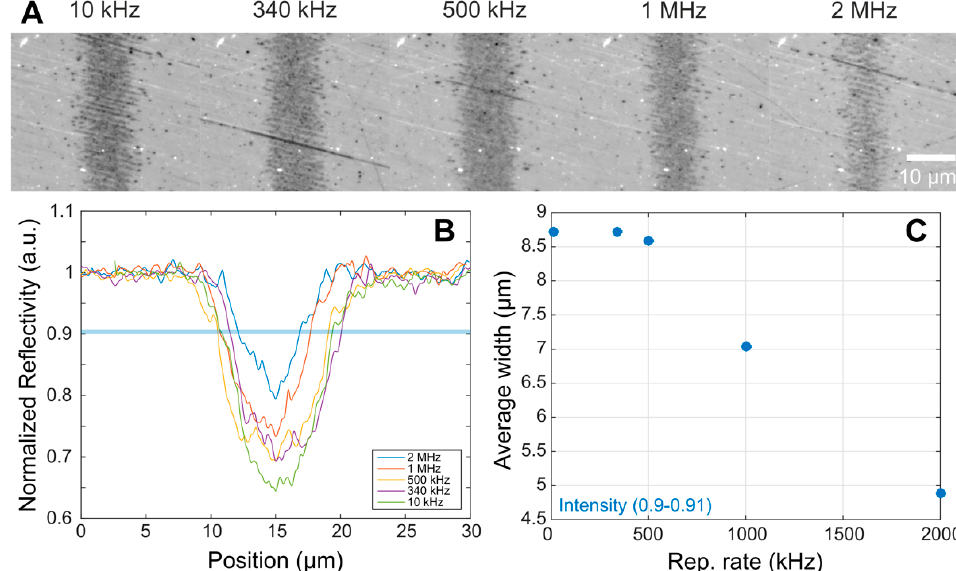
Figure 2. ( A ) Optical microscopy images of regular ablation lines ( N eff 1D = 10) produced at different repetition rates and constant near-threshold fluence ϕ = 225 mJ/cm 2 ; ( B ) Normalized reflectivity cross-sections of the lines shown in ( A ); and ( C ) Plot of the line widths measured within the reflectivity range 0.9 to 0.91 highlighted as a blue shaded line in ( B ).